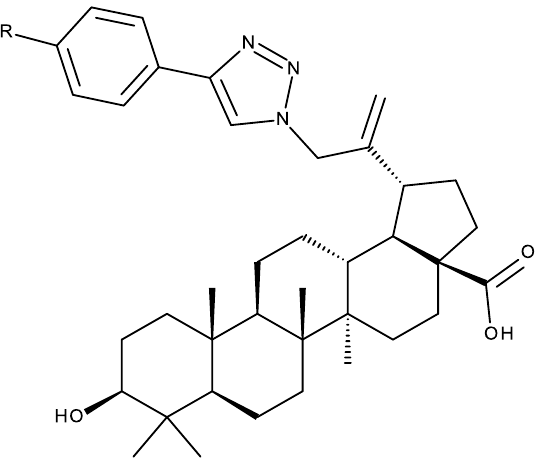
Figure 2. 1,2,3 − triazole − substituted derivatives of BA acid synthesized via click chemistry acting as Figure 2. 1,2,3−triazole−substituted derivatives of BA acid synthes ized via click chemistry acting as effective anti − leukemia effective anti−leukemia agents .